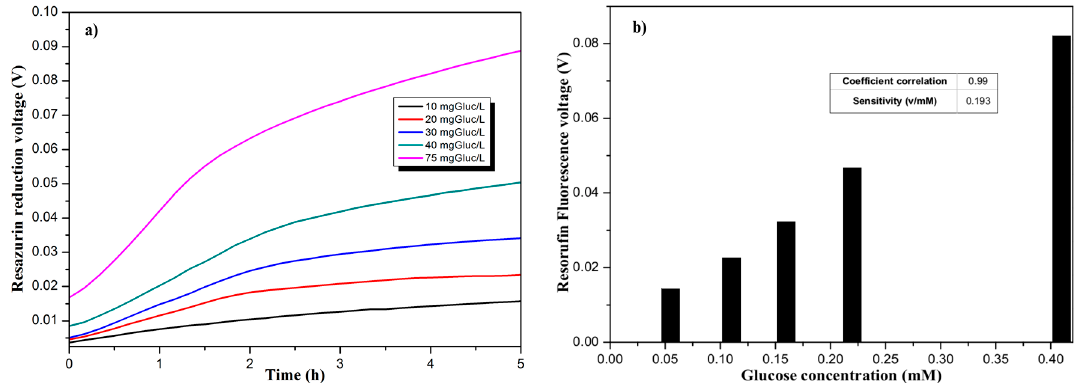
Figure 4. ( a ) Temporal evolution of the Resazurin reduction for different glucose concentrations; ( b ) Evaluation of the Resorufin fluorescence for different glucose